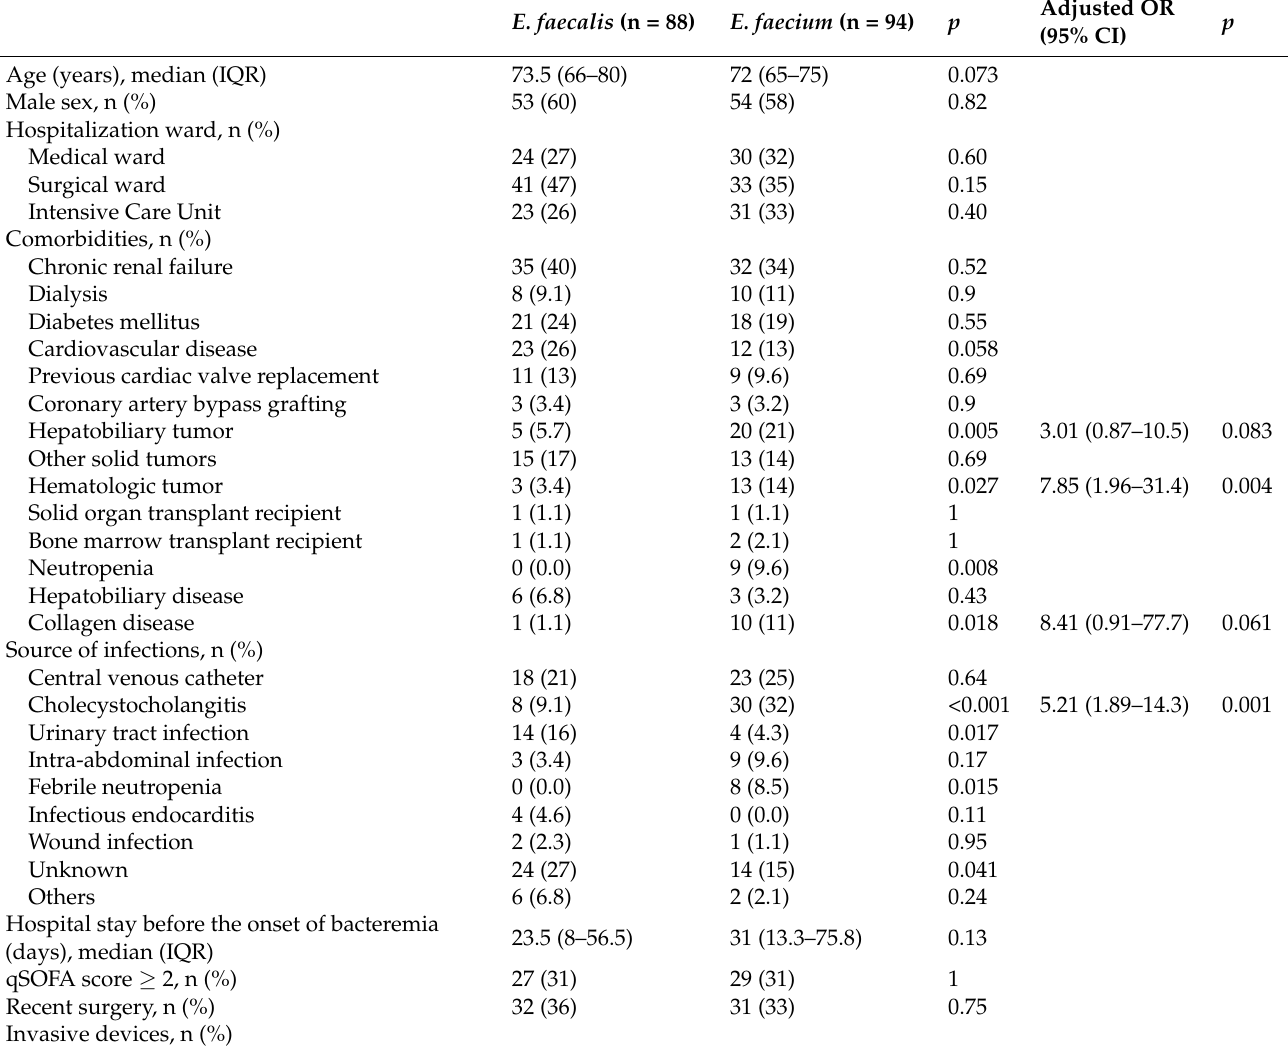
Table 1. Intergroup comparison of demographic and clinical characteristics of patients with enterococcal bacteremia and risk factors for the acquisition of E. faecalis and E.